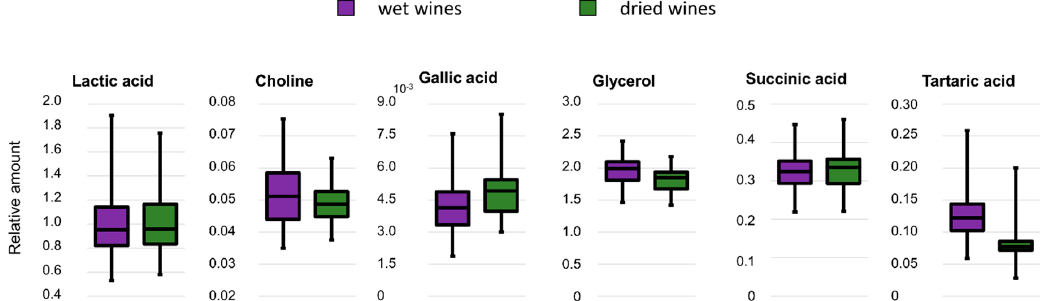
Figure 5. Box and whiskers plots showing the variability distribution of lactic acid, choline, gallic acid,